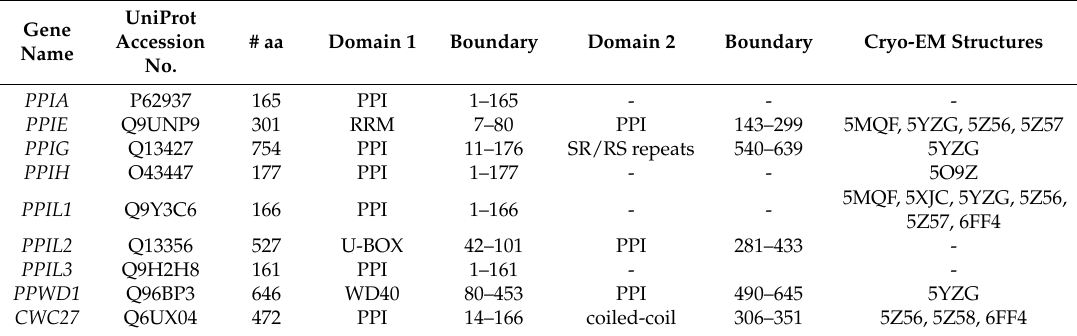
Table 1. Annotation of the nuclear